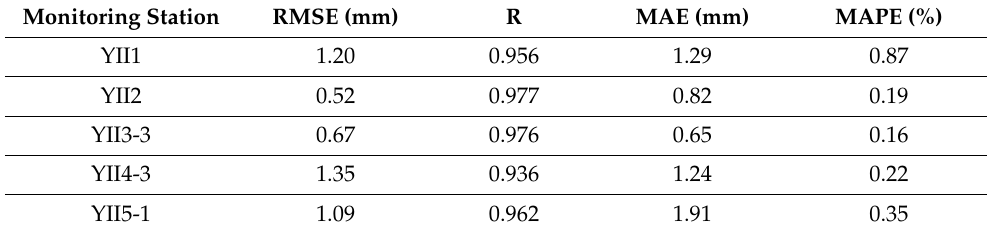
Table 6. Evaluation indexes of the testing set of surface monitoring points for the LSTM model. Monitoring Station